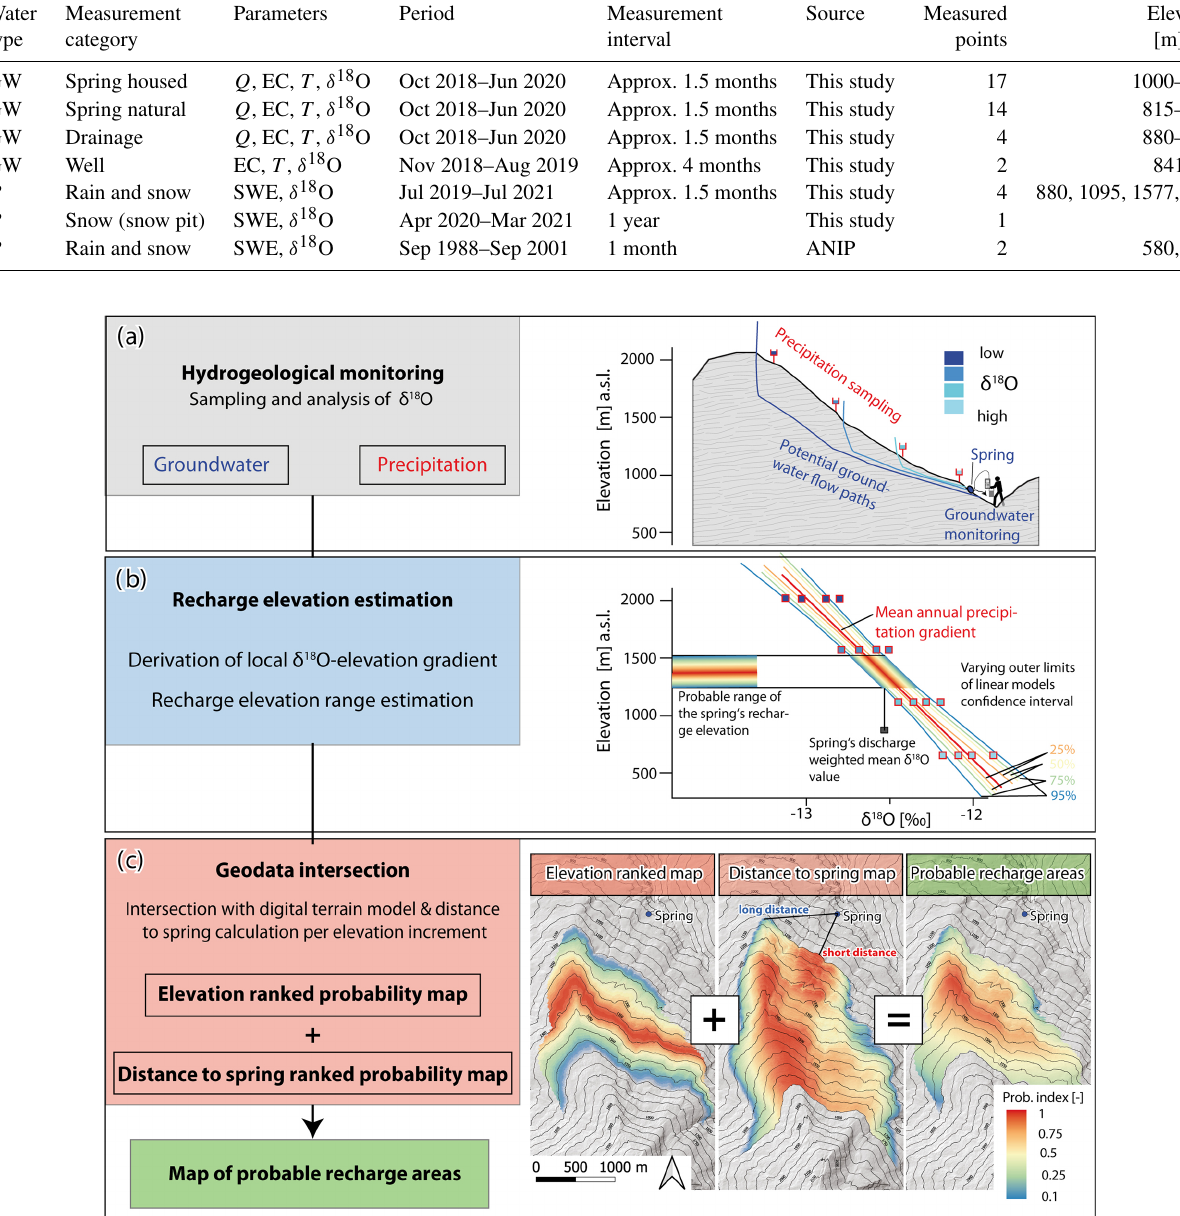
Figure 3. Proposed workflow for deriving maps of probable recharge areas including (a) hydrogeological monitoring, (b) recharge elevation estimation, and (c) geodata intersection (DTM source: Federal State of